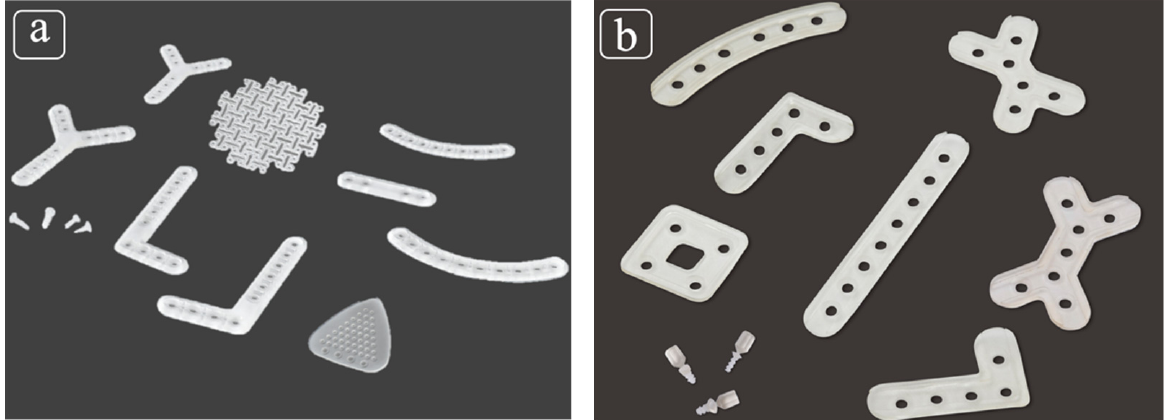
Figure 1. ( a ) RapidSorb ® , a copolymer of poly-L-lactic acid (PLLA) (85%) and polyglycolic acid (PGA) (15%); ( b ) Lactosorb ® , a copolymer of PLLA (82%) and PGA (18%).